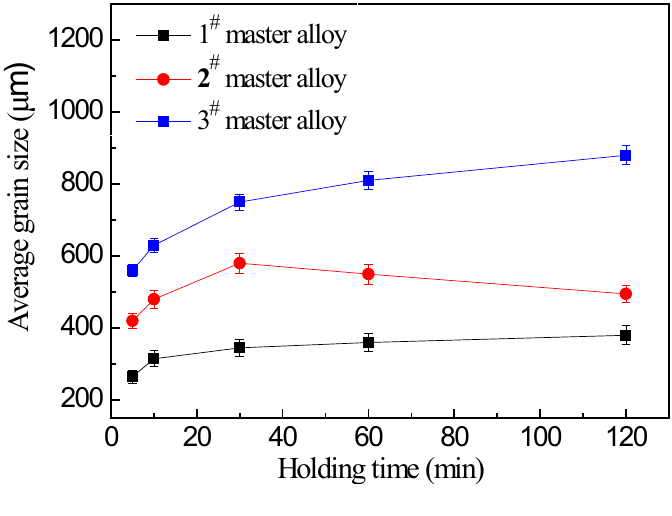
Figure 11. The relation curve between holding time and the average size of solidified commercial pure aluminum samples refined with 1.0 wt% master alloy 1 # –3 #